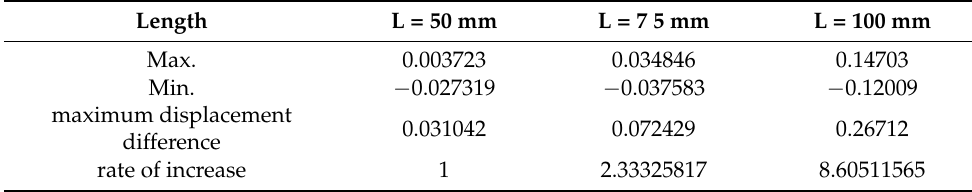
Table 2. Vibration displacement along PVDF piezoelectric body length.